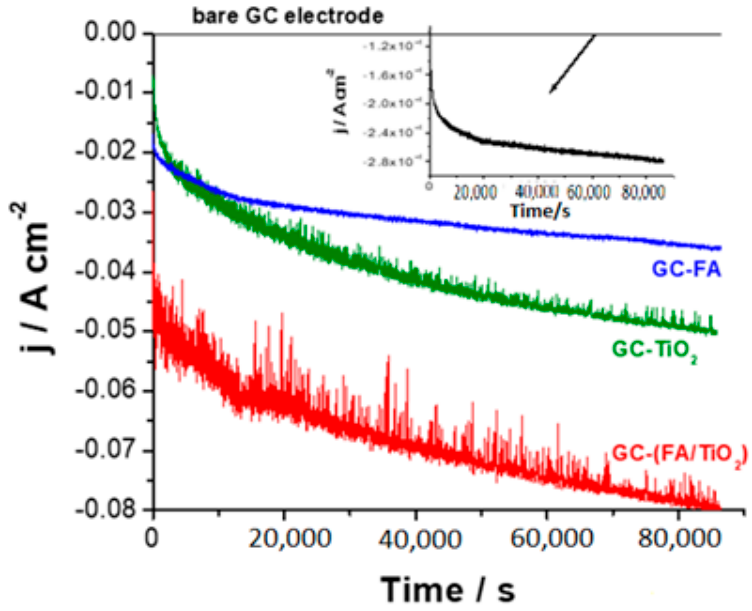
Figure 7. 24 h of Chronoamperometry measurements recorded for the investigated catalysts in deaerated 0.1 M KOH solution at − 1.0 V (vs. RHE) at room temperature. Inset—the arrow refers to a zoomed chronoamperometry curve recorded for the bare GC electrode.